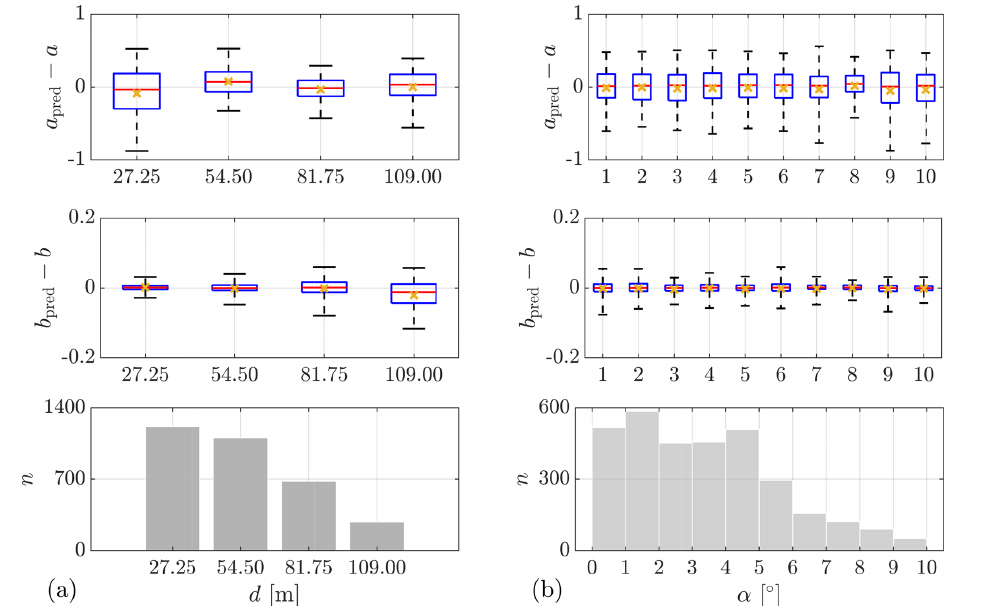
Figure 16. Prediction errors of a (case 6) and b (case 11) from Lidar Complex with respect to the values of predictors. (a) Measurement separation d . (b) Misalignment angle of wind direction and lidar measurement α . n is the sample size. The bottom and top of the boxes indicate the first and the third quartiles, i.e., 25th and 75th percentile, respectively. The lower and upper whiskers show the 5th and 95th percentiles. The red line and the yellow cross in the middle indicate the median and mean value,